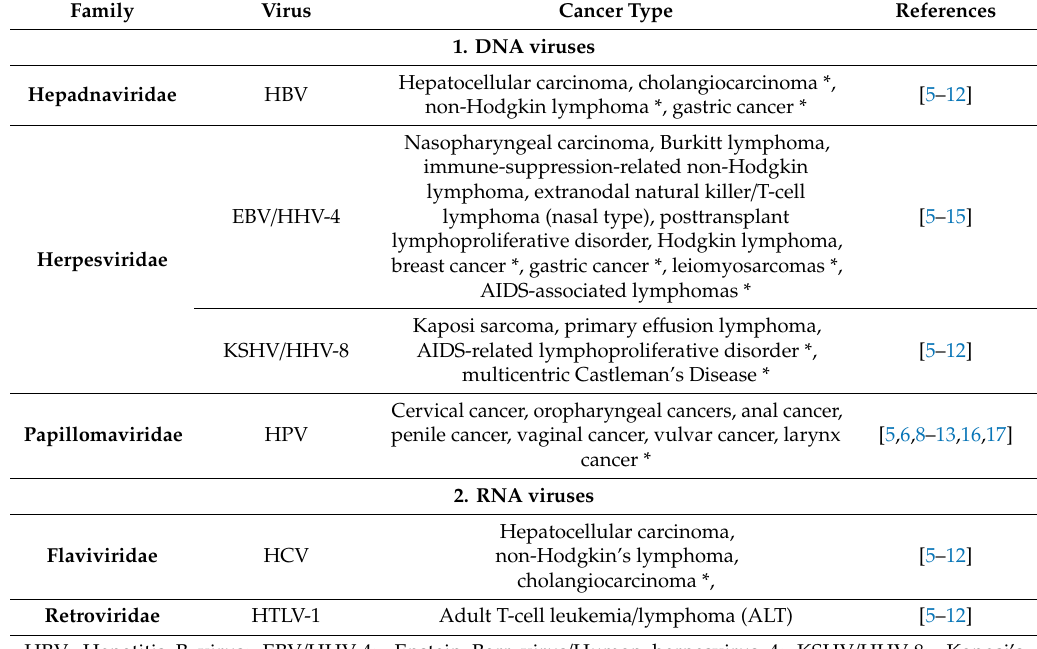
Table 1. Human oncogenic virus.